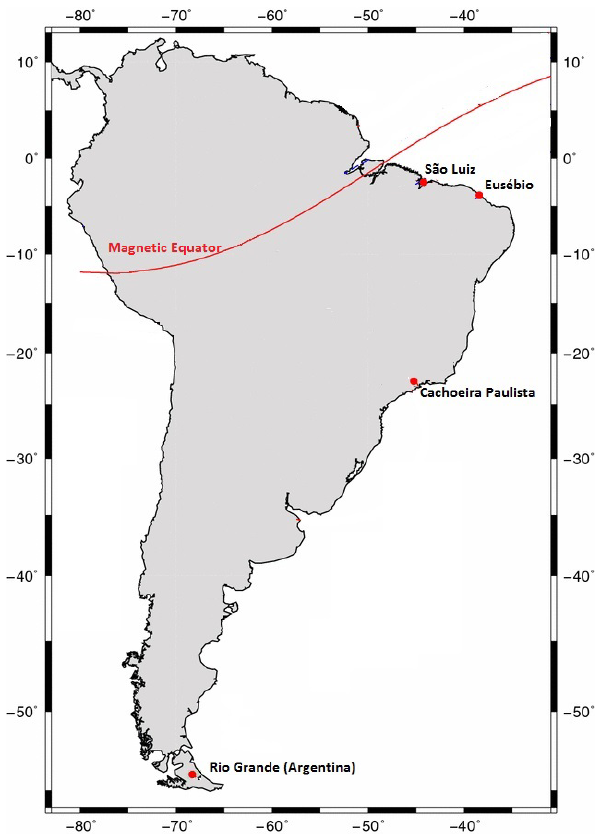
Figure 1. Locations of the magnetometer stations in South America (source: adapted from Padilha et al.,